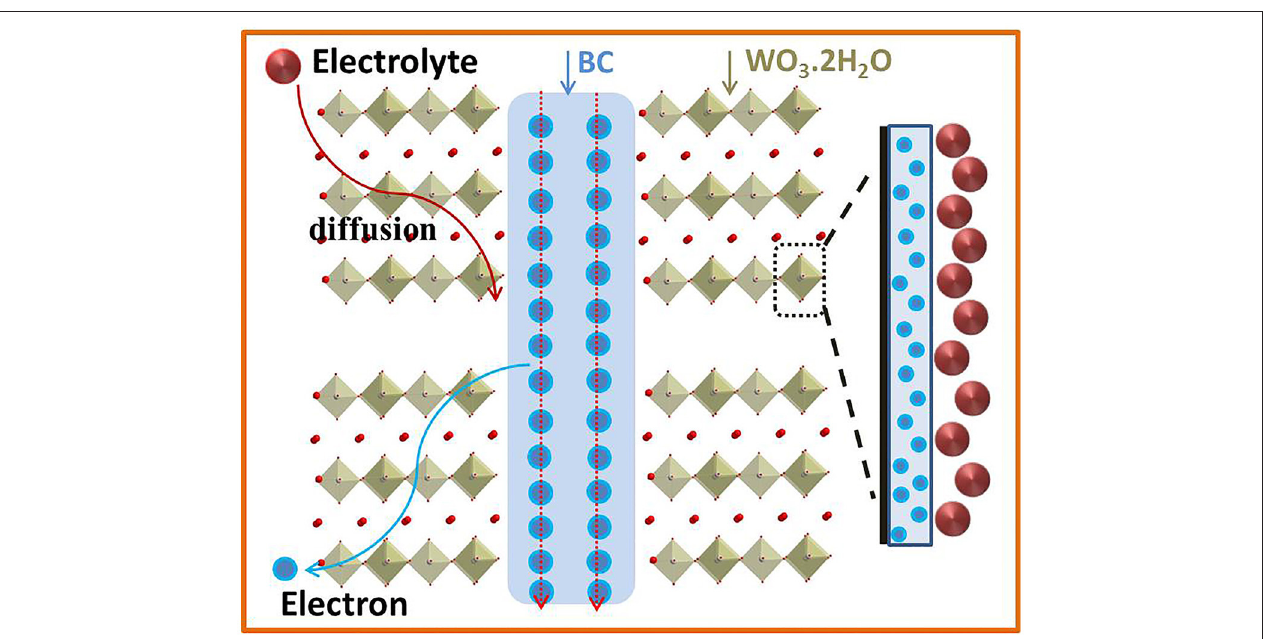
FIGURE 7 | Anchored WO 3 .2H 2 O crystals with conductive BC; both electron and electrolyte can access WO 3 .2H 2 O surfaces, and an enhanced pseudocapacitive process can be formed on the surface of WO 3 .2H 2 O/BC.